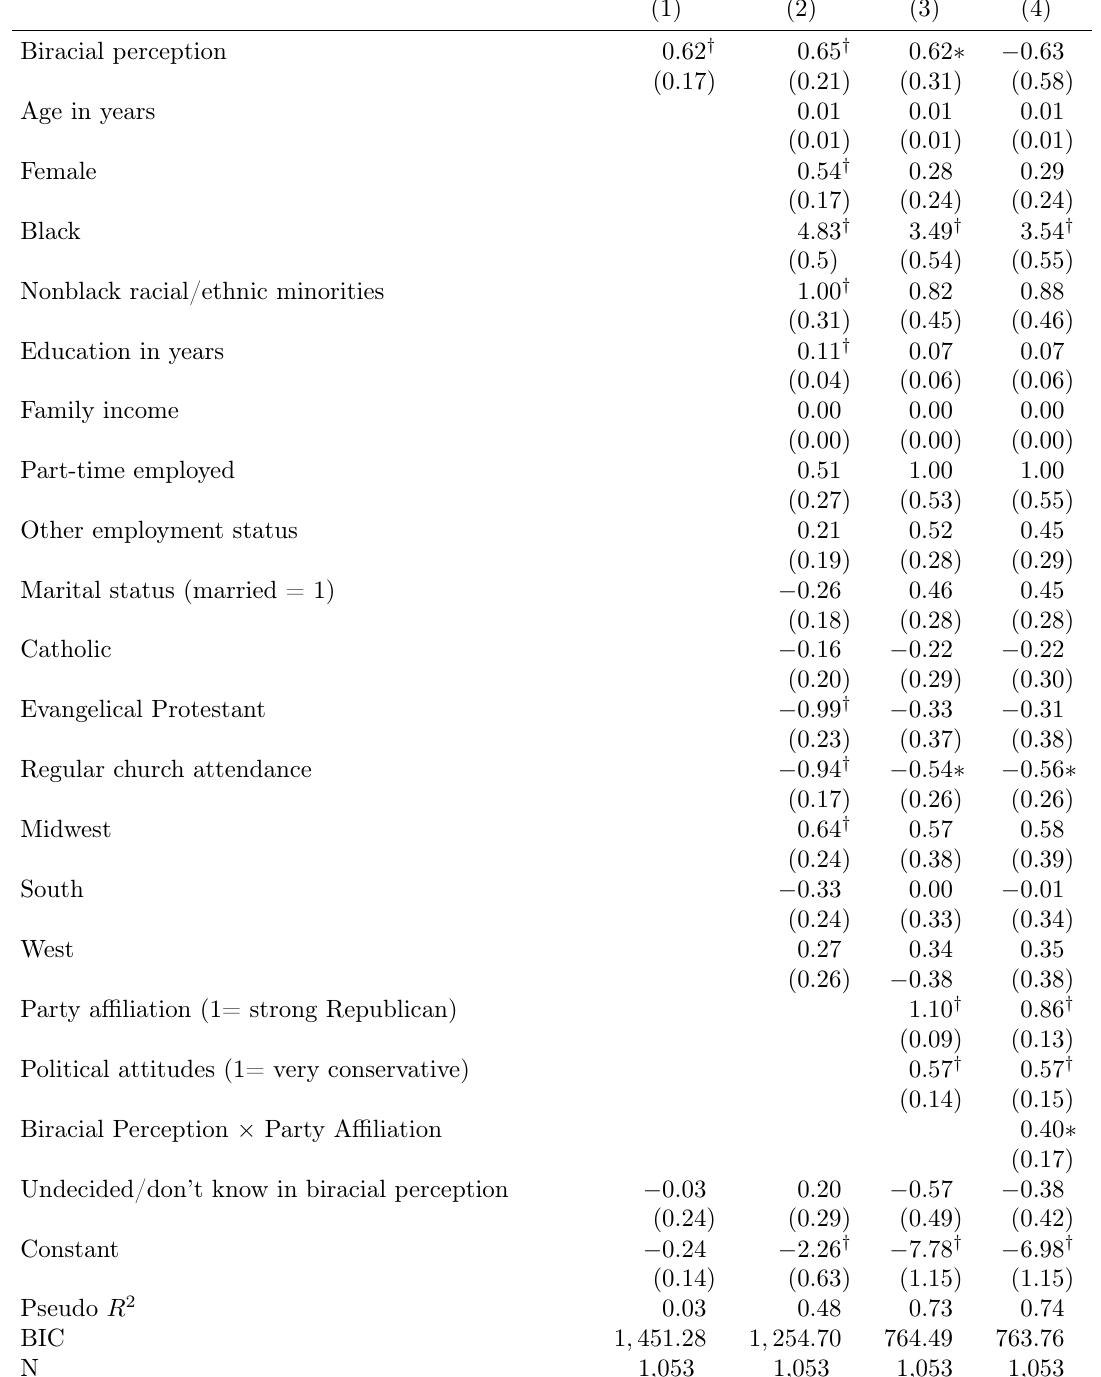
Table 3: Weighted Logistic Regression Analysis of Biracial Effects on Support for Barak Obama over John